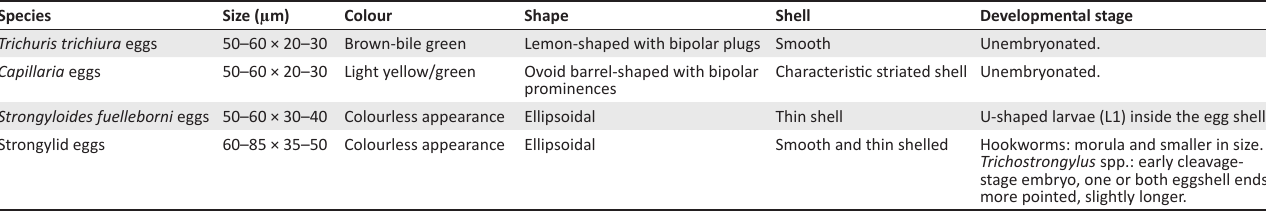
TABLE 1 : Morphologic identification guidelines followed for egg identification. Species Size ( µ m) Colour Shape Shell Developmental stage